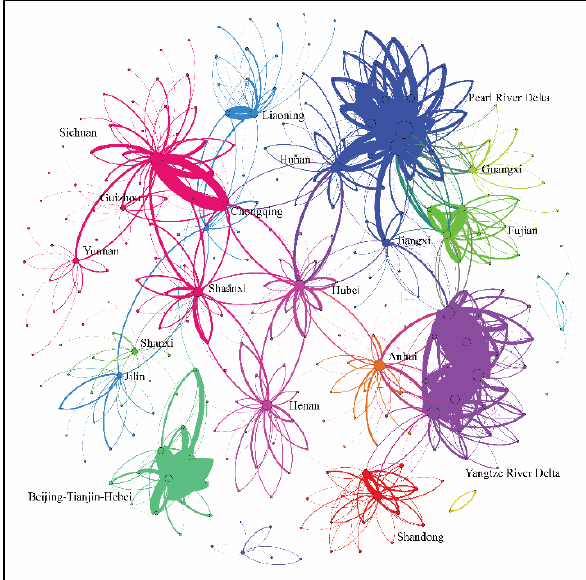
Figure 2 The community structure based on the migration flows ( l >16). Different colors represent different community affiliations, the size of the node indicates the number of cities connected to it, the width of the line shows the intensity of migration